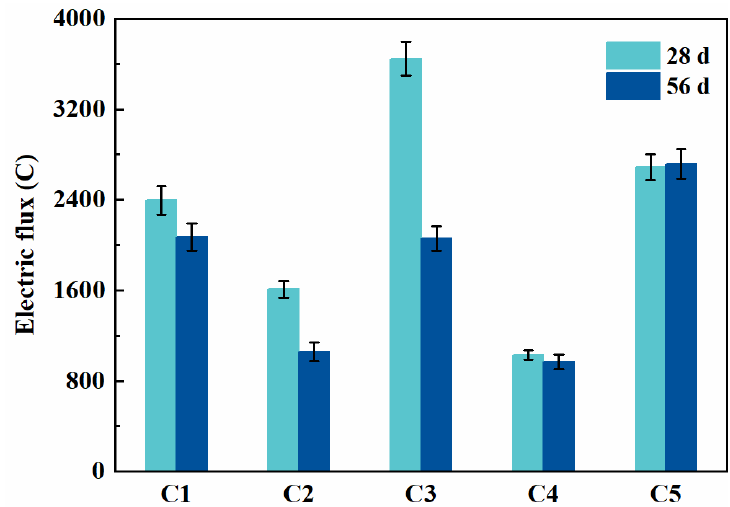
Figure 5. Electric flux of SCC at 28 and 56 days.